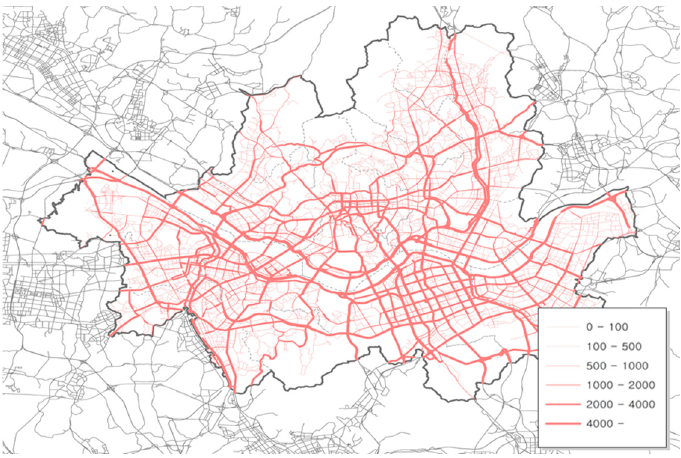
Figure 11. Traffic volume distribution in Seoul using cell phone application data (veh./day).